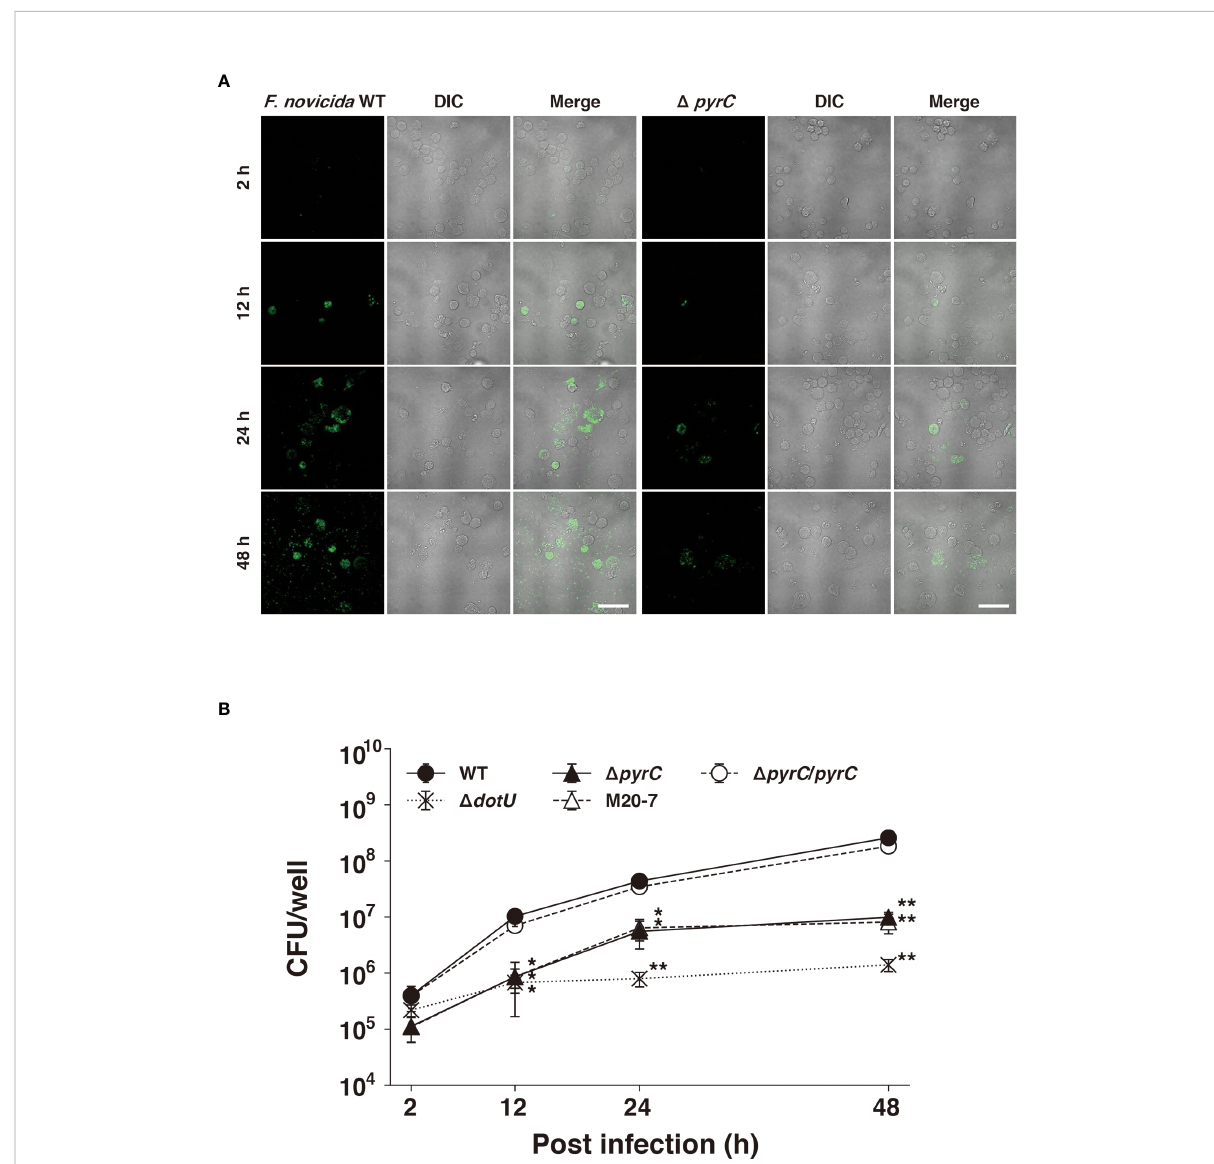
FIGURE 3 Intracellular growth of the pyrC deletion mutant. (A) U937 cells were infected with GFP-expressing F novicida strains at an MOI of 1 and treated with 50 m g/ml of gentamicin for 1 (h) At 2 – 48 h post infection, the cells were fi xed and observed by FV1000 confocal laser scanning microscopy. Scale bar: 20 m m. (B) U937 cells were infected with F novicida strains at an MOI of 1 and treated with 50 m g/ml of gentamicin for 1 (h) At indicated time points post infection, cells were disrupted with 0.1% Triton X-100 and plated on BHIc agar; colony forming units were then counted. Data shows averages and standard deviations from three independent experiments. Differences compared with the wild-type strain were determined by Dunnett ’ s multiple comparison and are indicated by asterisks ** P < 0.01, * P <